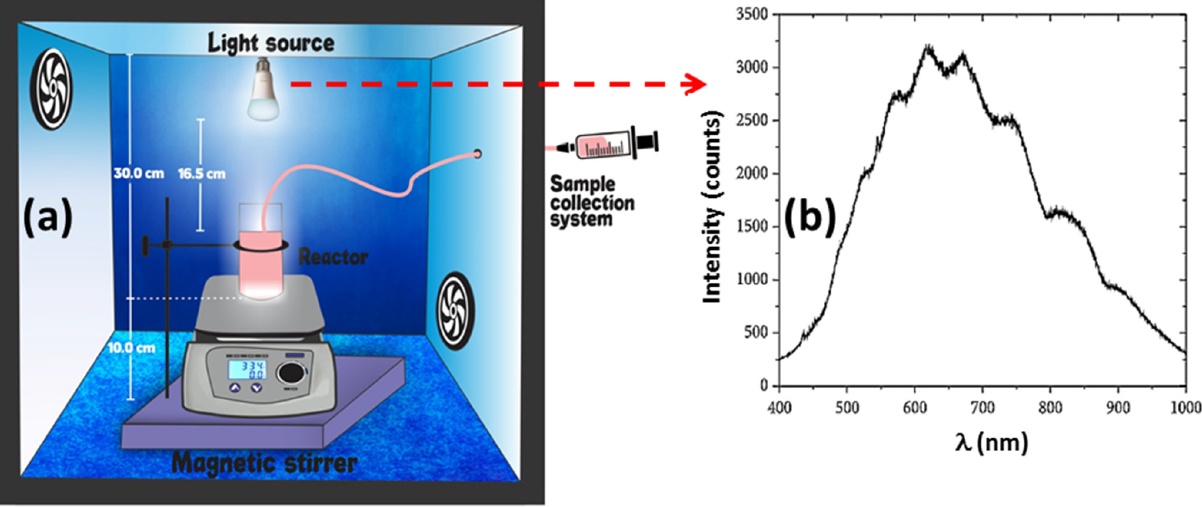
Figure 2. ( a ) Experimental apparatus for photocatalysis tests; ( b ) emission spectrum of white light applied during the photocatalysis experiments.